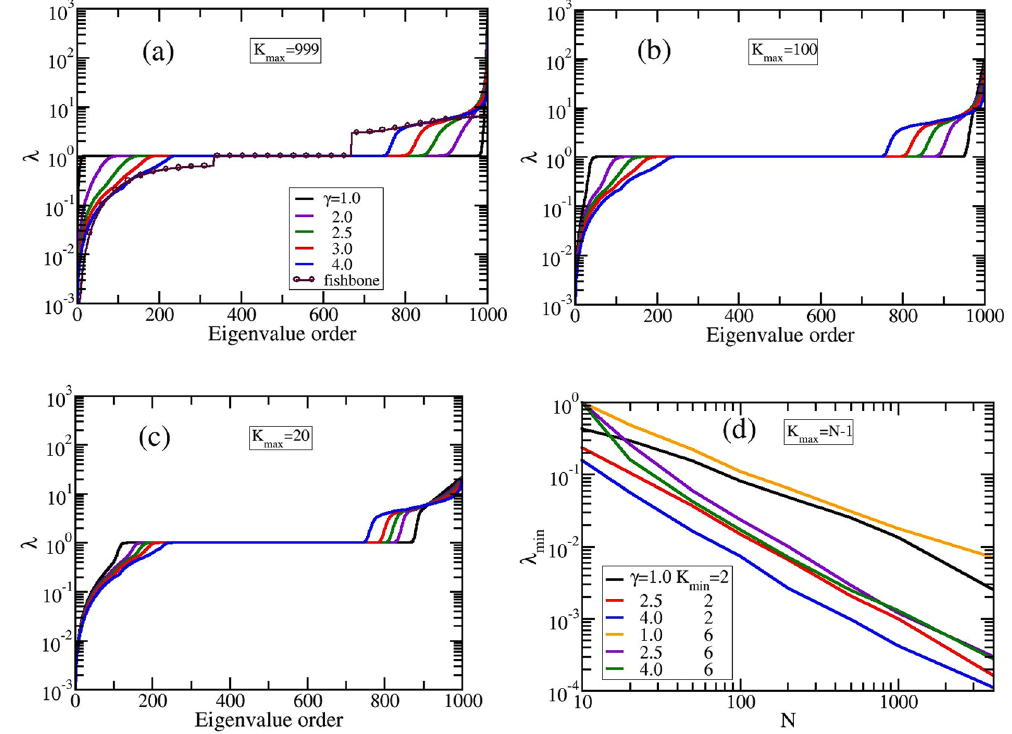
Figure 6. ( a – c ) Eigenvalues in progressive order for GSFPNs with N = 1000 and K min = 4. ( d ) Lowest nonzero eigenvalue as a function of the network